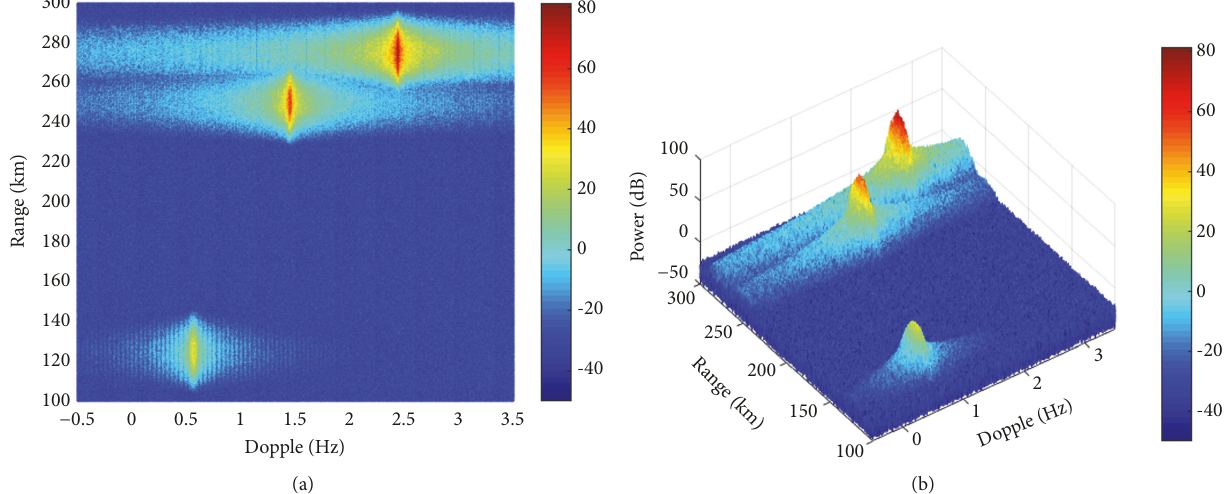
Figure 8: Simulated oblique backscattering PSD of ionospheric clutter: (a) R-D spectrum. (b) 3D spectrum.